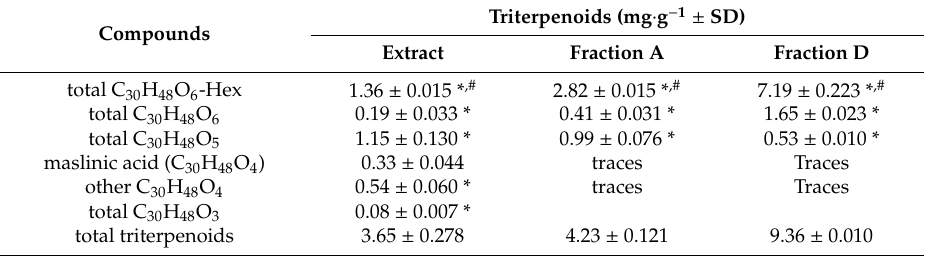
Table 3. Content of triterpenoids in the extract from paulownia Clone in Vitro 112, and its fractions.